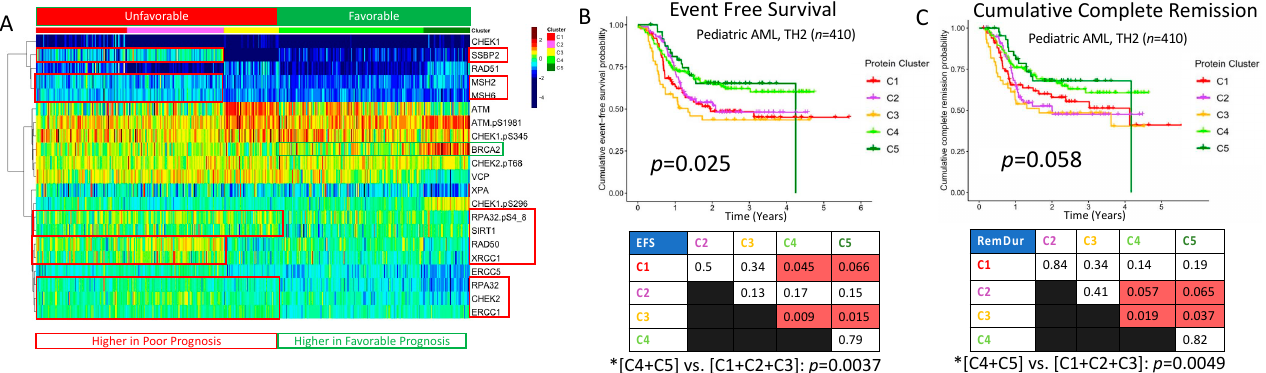
Figure 6. DDR proteins reveal five pediatric clusters with significantly different prognoses. An alternate set of 21 DDR proteins from the pediatric RPPA array was used to identify five clusters of pediatric patients with variable clinical outcomes. ( A ) Heatmap derived from 21 DDR proteins ( n = 410) for five pediatric AML clusters. C1 (red), C2 (lavender), and C3 (yellow) represent unfavorable prognosis clusters while C4 (lime) and C5 (forest green) represent favorable prognosis clusters. Proteins downregulated in expression relative to normal CD34+ cells are colored in cooler colors approaching deep blue, while upregulated proteins are colored in warmer colors approaching burgundy. ( B ) Associated event-free survival (EFS), and ( C ) associated RD. Pairwise comparisons between clusters for both EFS and RD are shown beneath the cumulative probability curves in ( B ) and ( C ), respectively.